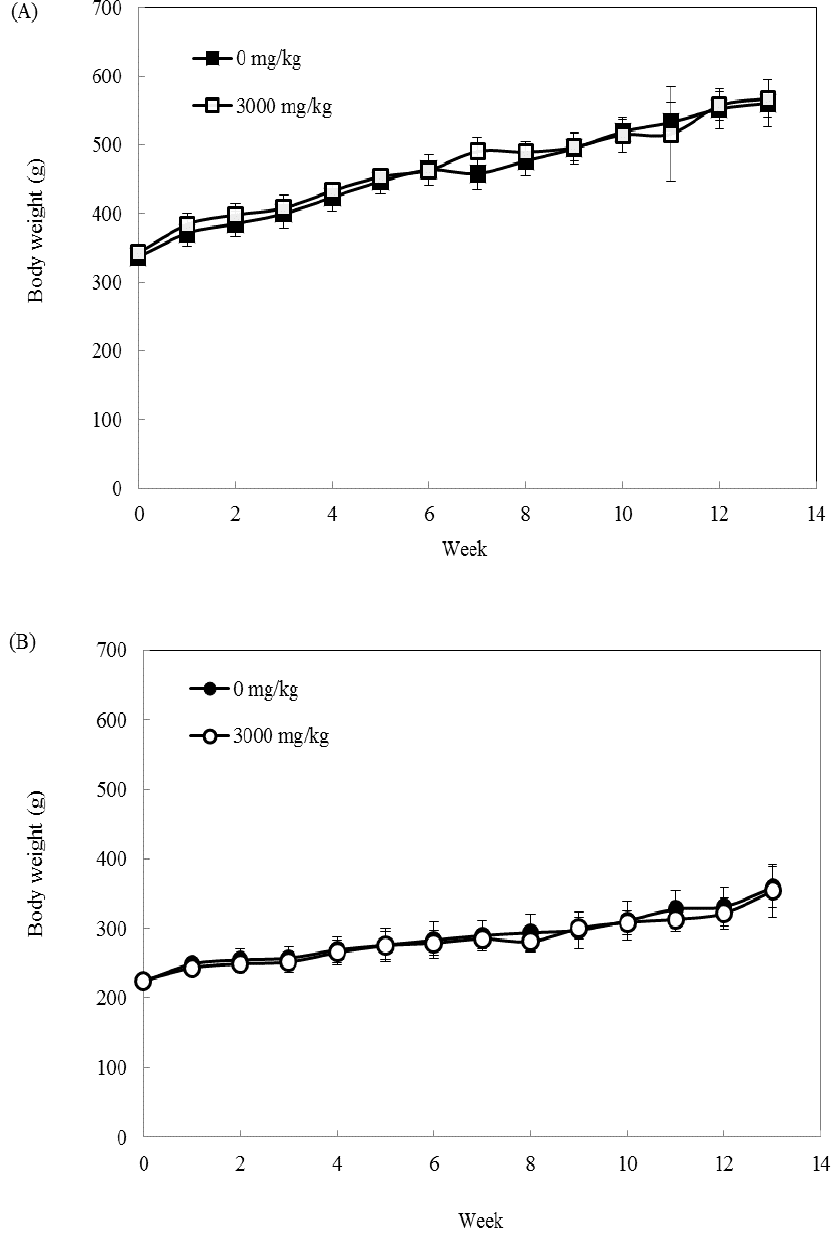
Figure 4. Body weight changes of ( A ) male and ( B ) female SD rats during the 90-day safety assessment. Data are expressed as mean ± S.D. (n = 6).